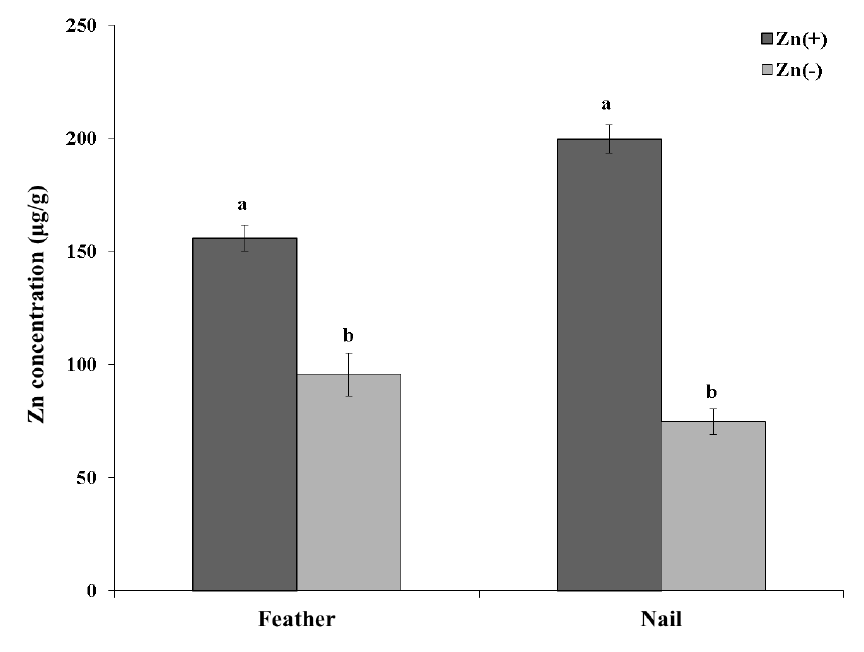
Figure 2. Chicken feather and nail zinc concentrations (day 28). a,b Within each parameter, means without a common letter are statistically significant (means ± SEM, n = 12, p <